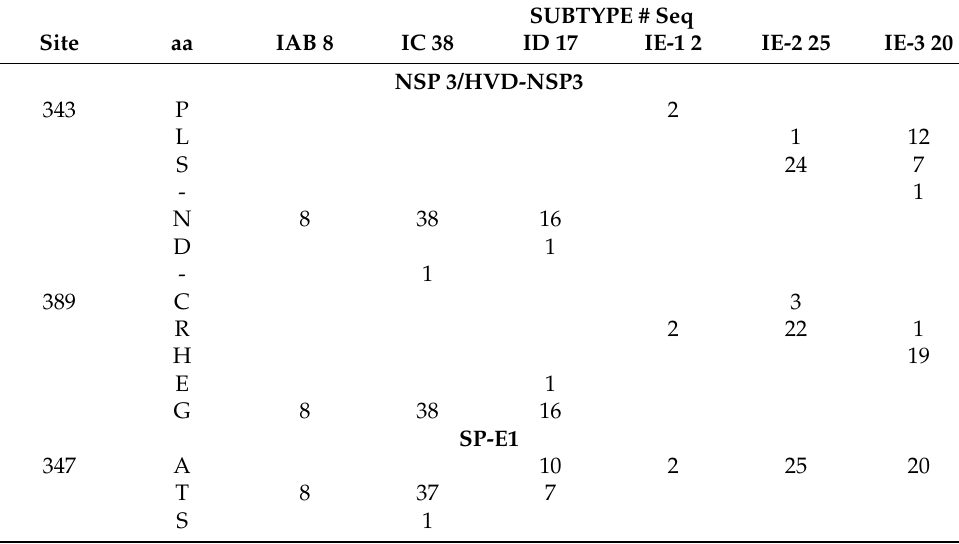
Table 2. Amino acid distribution in sites with positive